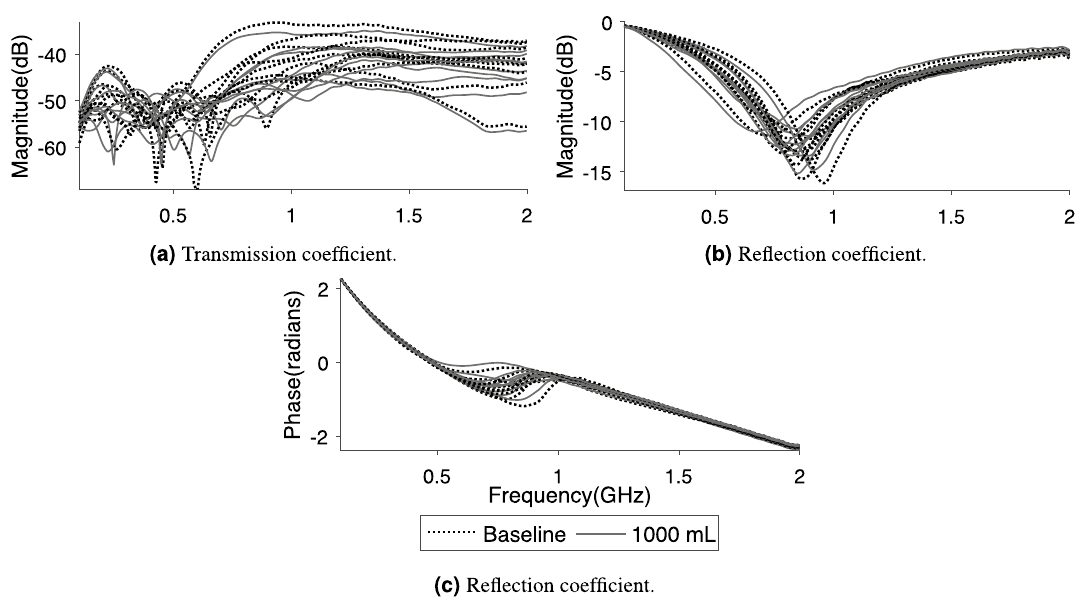
Figure 5. Examples ( S 75 + 86 and S 77 + 88 ) of the large baseline difference between ten subjects in relation to the changes caused by hemoperitoneum. The data from the two groups completely overlap, and hemoperitoneum cannot be visually separated from healthy